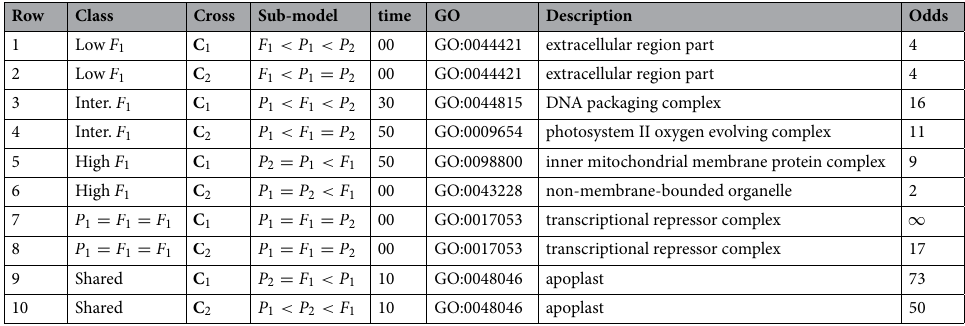
Table 9. Enriched “Cell Component” (CC) with the highest odds per combination of class × cross.